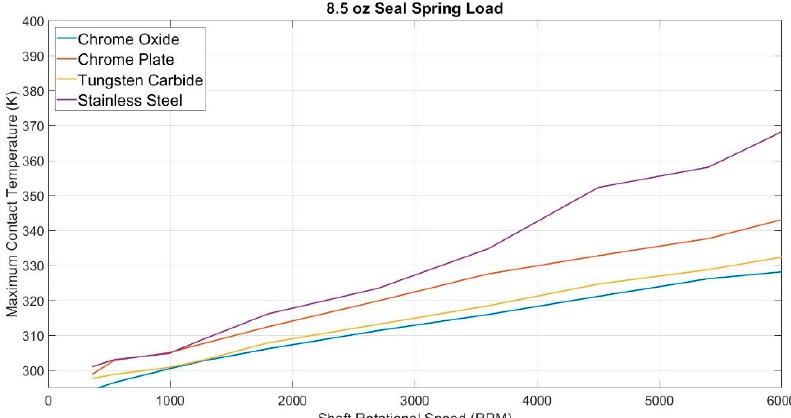
Figure 8. Maximum contact temperature at sealing interface for all 8.5 oz spring loads, comparing temperatures reached for CO, CP, TC and SS sleeves.